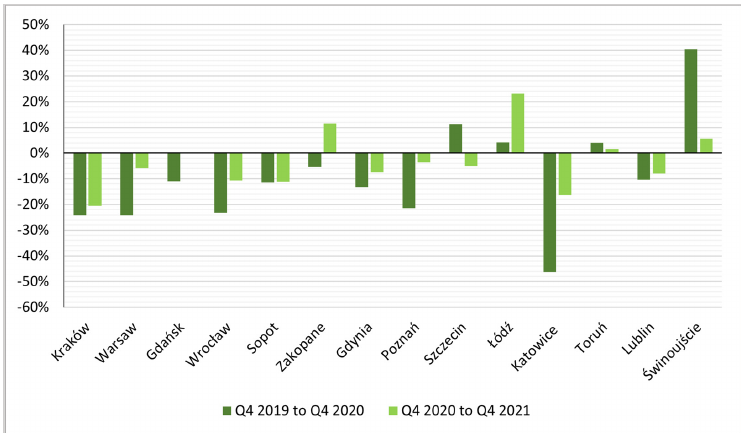
Figure 8. Indices of dynamics of changes, Q4 2019 to Q4 2020 and Q4 2020 to Q4 2021.